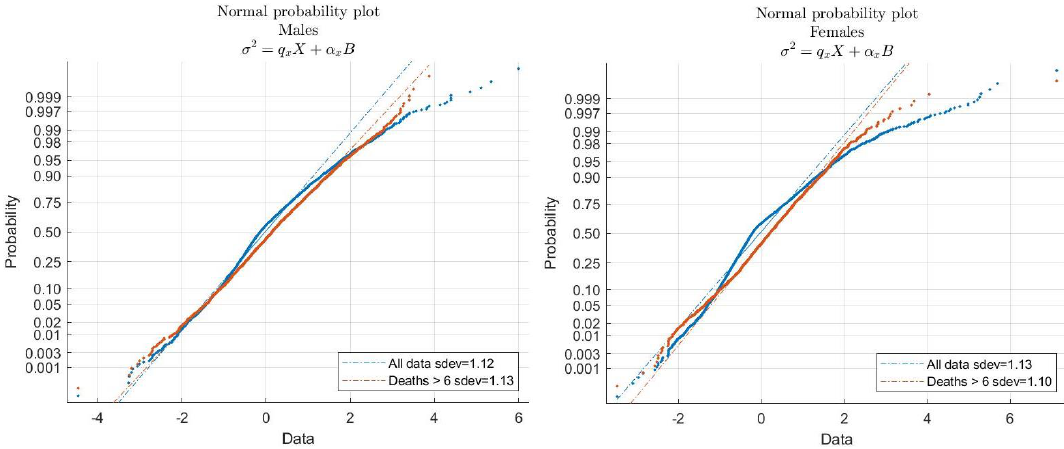
Figure 7. Normal probability plot—Poisson.